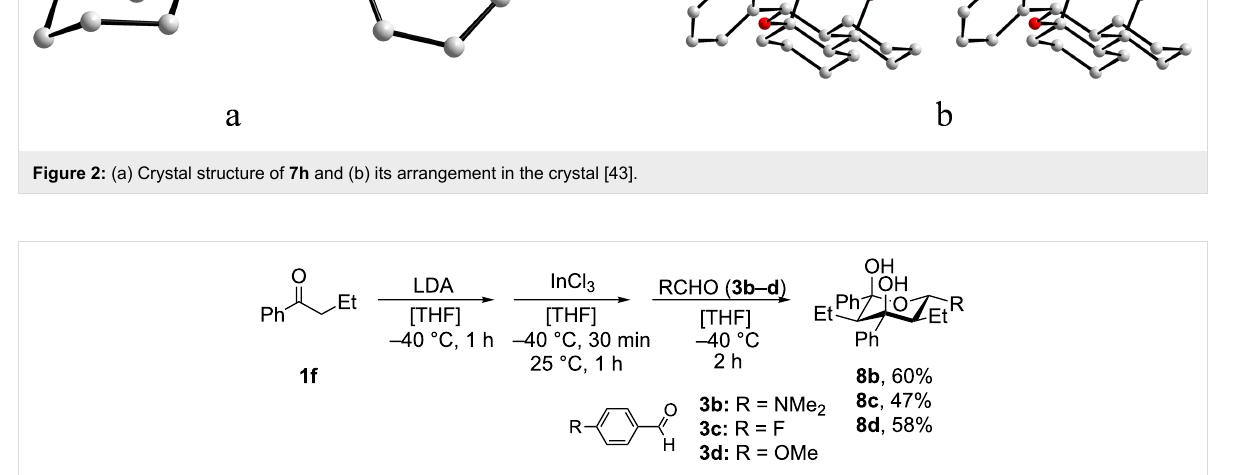
Scheme 4: Reaction of n -butyrophenone ( 1f ) with various aldehydes ( 3b − d ) in presence of InCl 3 (reaction time: 2 h, reaction temperature: 25 °C).